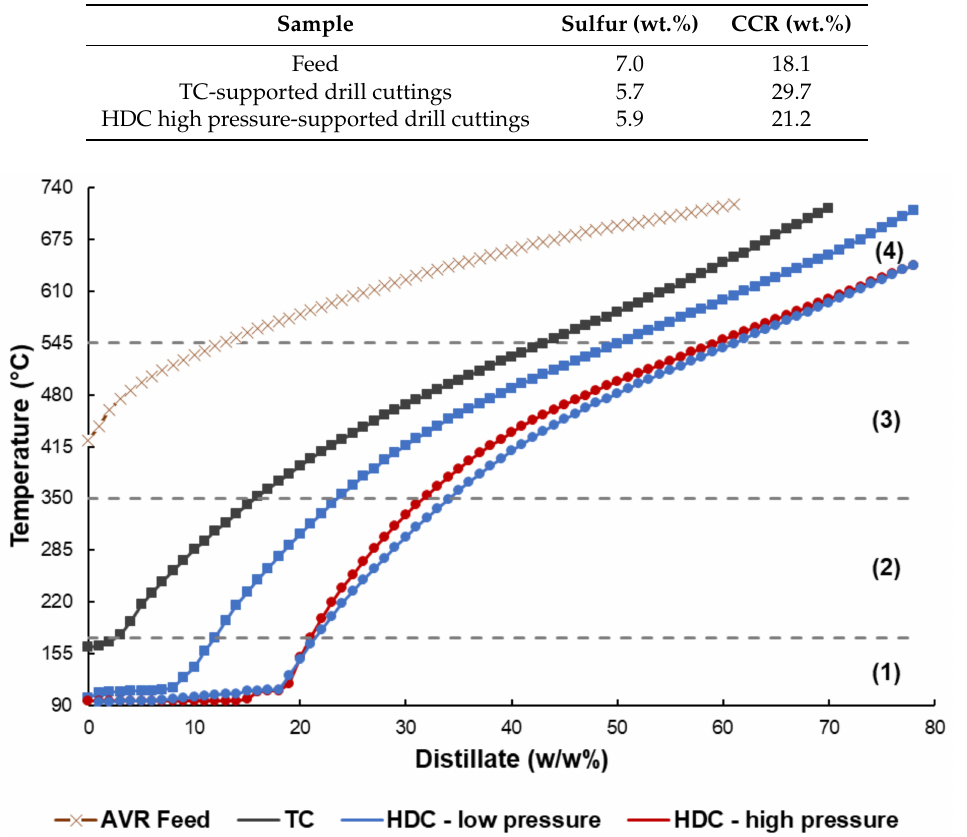
Figure 10. Simulated distillation curves for selected TC and HDC runs. The pressure was 70 psi and 365 psi for low and high-pressure runs, respectively. Control (square), raw drill cuttings (triangle), supported drill cuttings (circle). The sections are as follows: Volatiles (1), medium range distillates (2), high boiling point distillates (3), residue